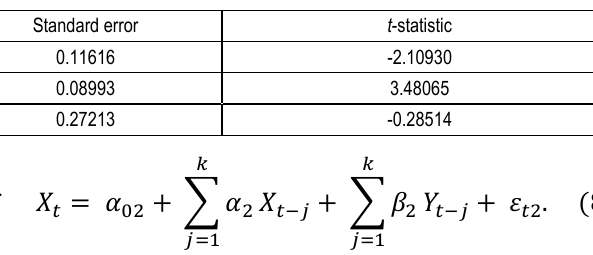
Table 8. Error Correction Model (ECM) results